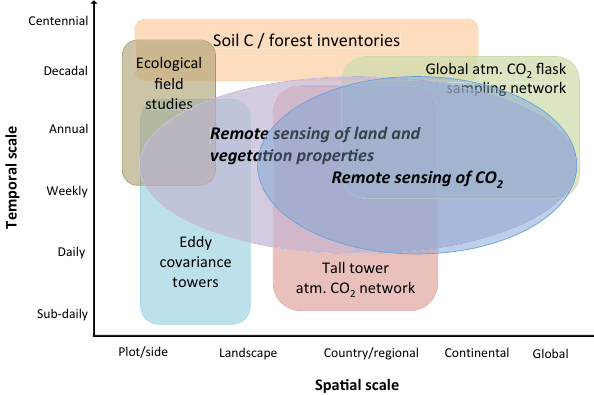
Figure 2. Space–time diagram for a range of observations relevant for a Terrestrial Carbon Observation